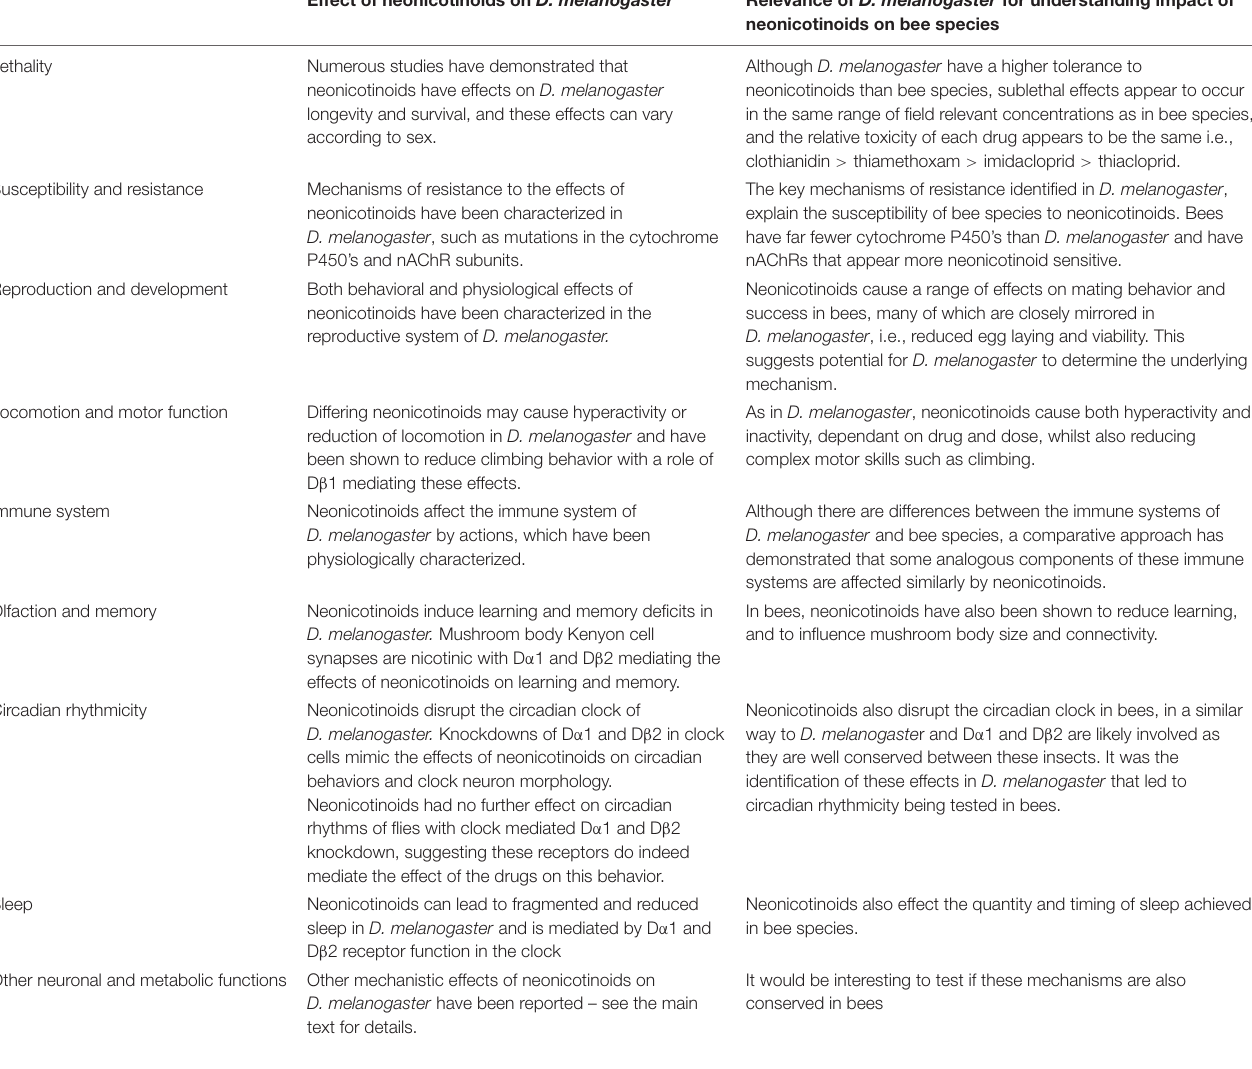
TABLE 2 | Summary of effects of neonicotinoids on D. melanogaster physiology and their ability to models the effects on bee